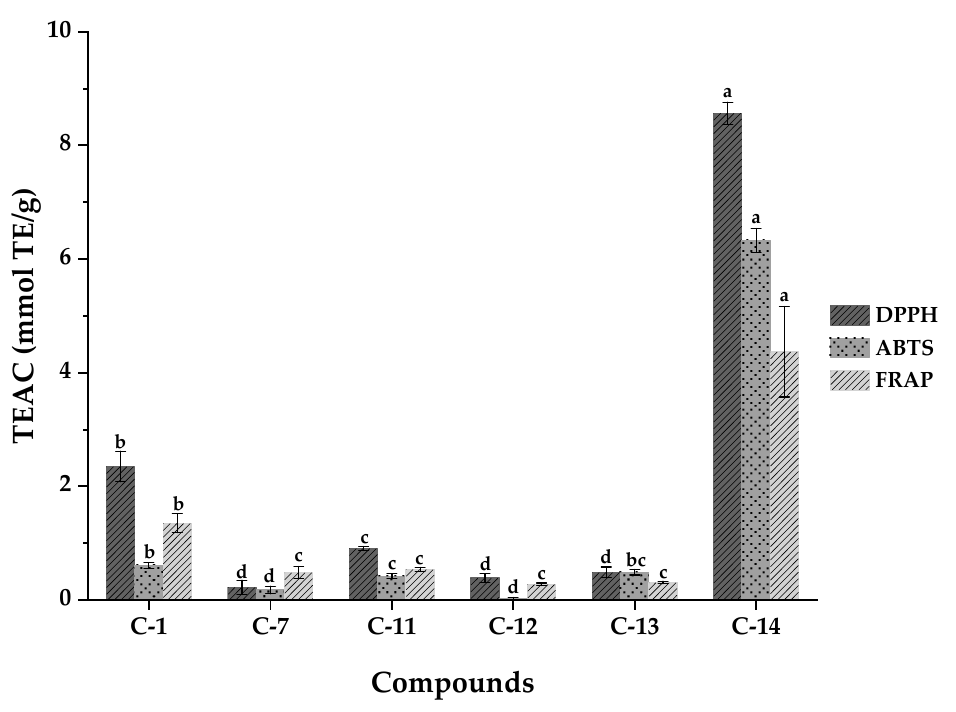
Table 4. Antioxidant activities of compounds isolated from WUE-A4 tested by DPPH, ABTS, and FRAP assays.